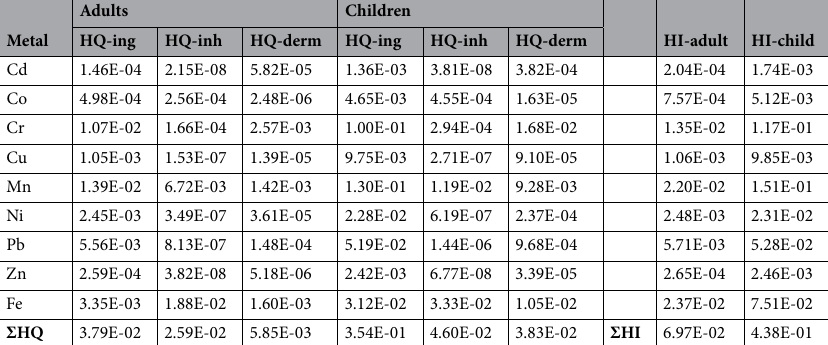
Table 6. Values of HQ and HI through ingestion, inhalation and dermal contact routes.